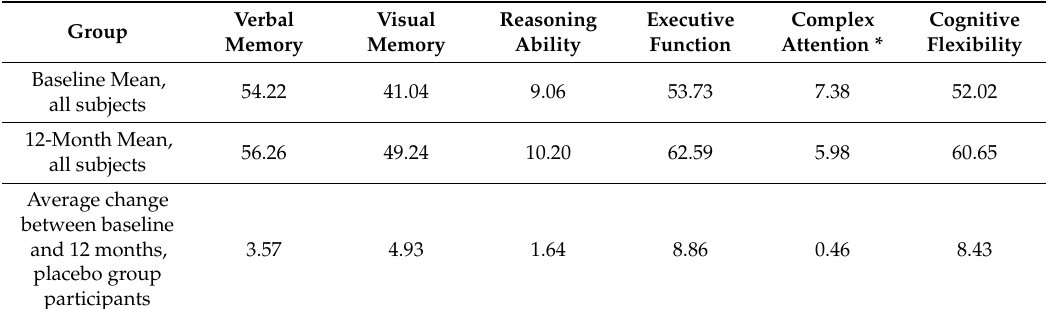
Table 5. Practice effects demonstrated by improvement in cognitive function across domains, regardless of supplementation status.